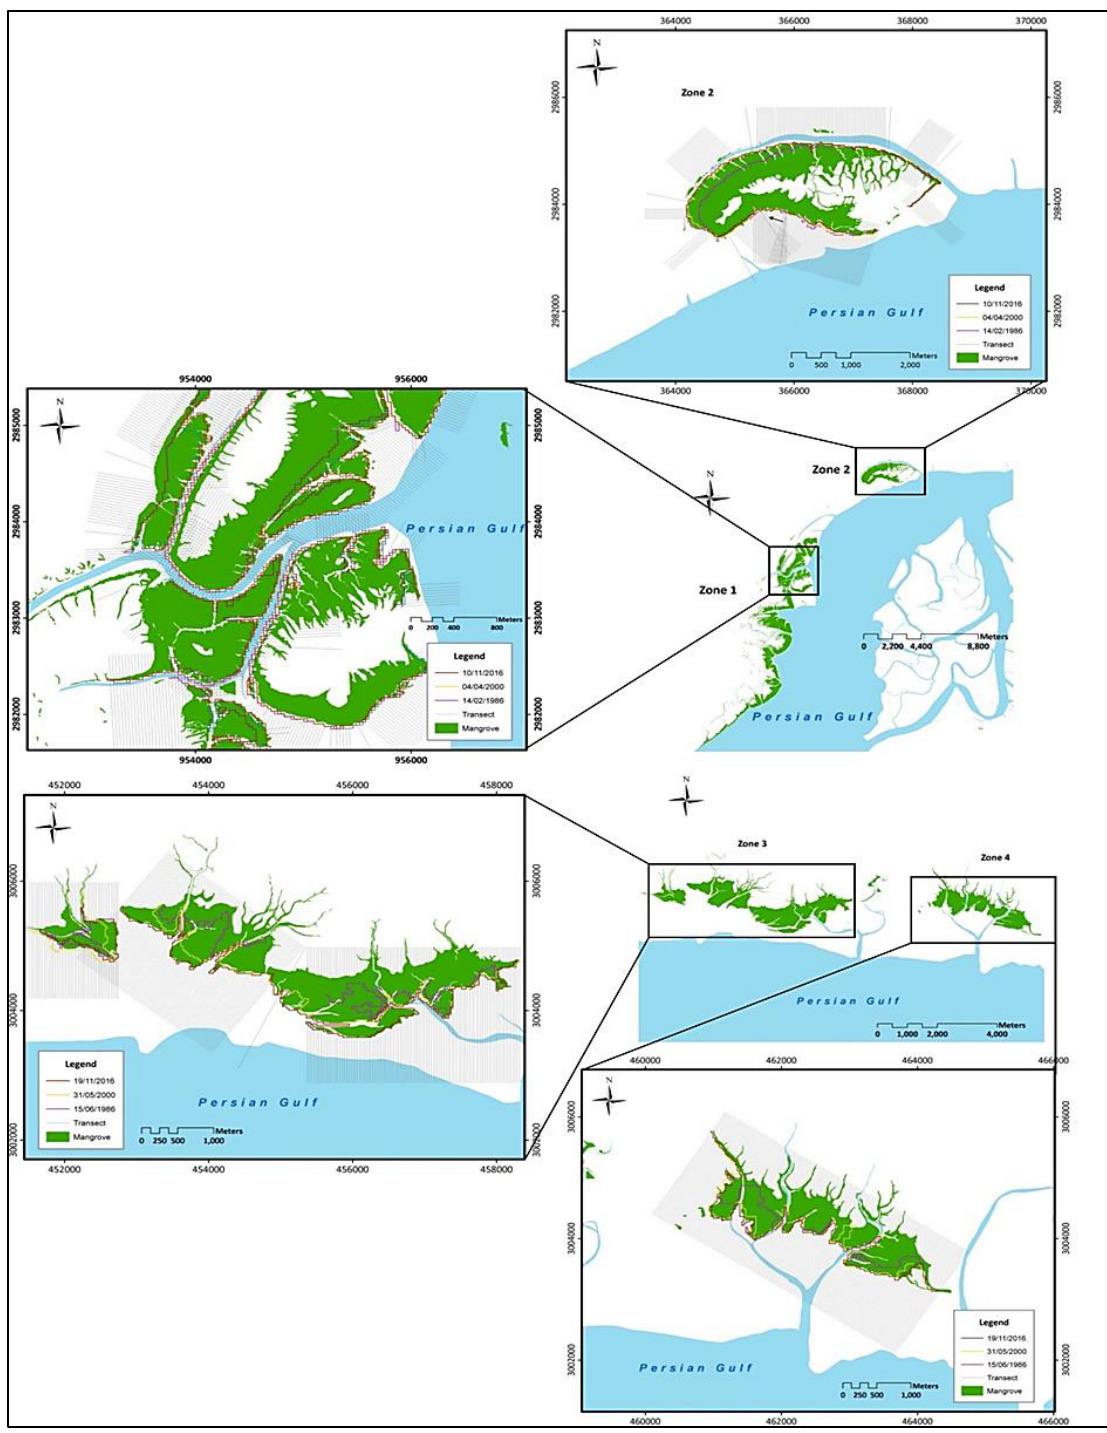
Figure 2. Shorelines changes of mangroves in Khamir habitat during 30-year